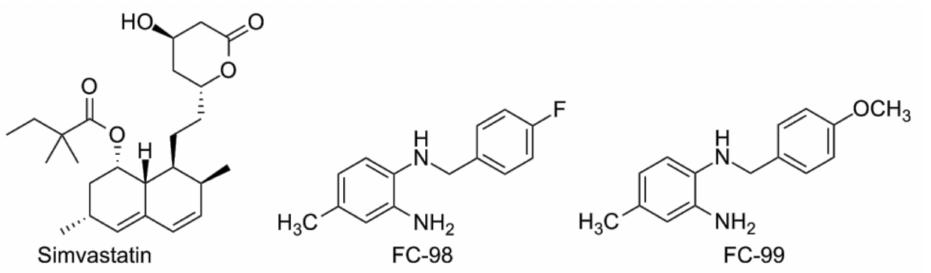
Figure 8. Simvastatin, FC-98 and FC-99 (from left to